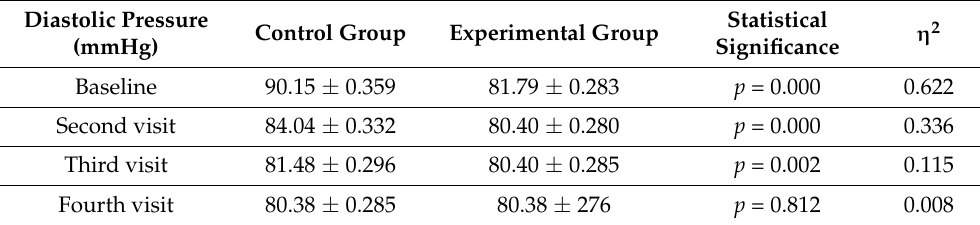
Table 3. Values of diastolic blood pressure in the study population. Results are presented as mean ± standard means of errors (X ± SEM) in control and experimental groups. Statistical difference was confirmed by Mann–Whitney U test. An eta-squared ( η 2 ) value reflects the strength or magnitude related to a main or interaction